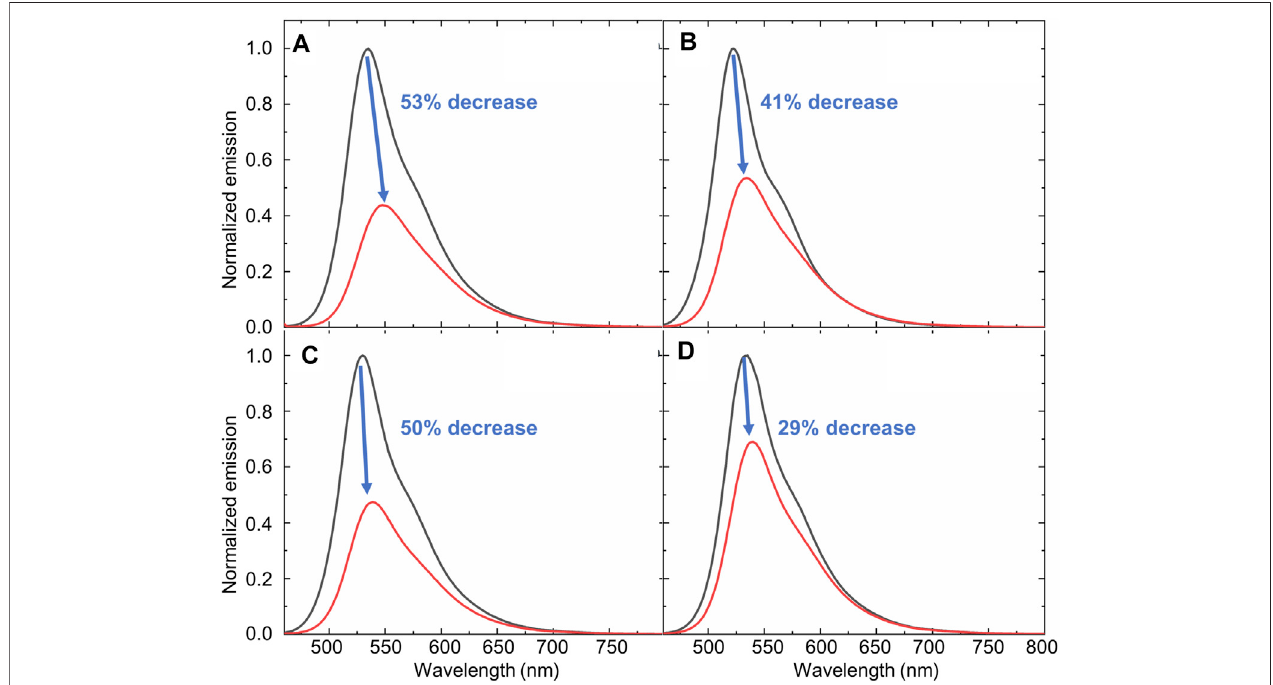
FIGURE3| Anillustrationofthechangesinthe fl uorescenceemissionofcompound 1 thatoccursintheabsence(blackline)orpresence(redline)ofwaterinwater- miscible organic solvents: (A) Acetonitrile; (B) THF (C) DMF; and (D) DMSO. [( 1 ) (cid:1) 10 μ M; λ ex (cid:1) 450 nm].